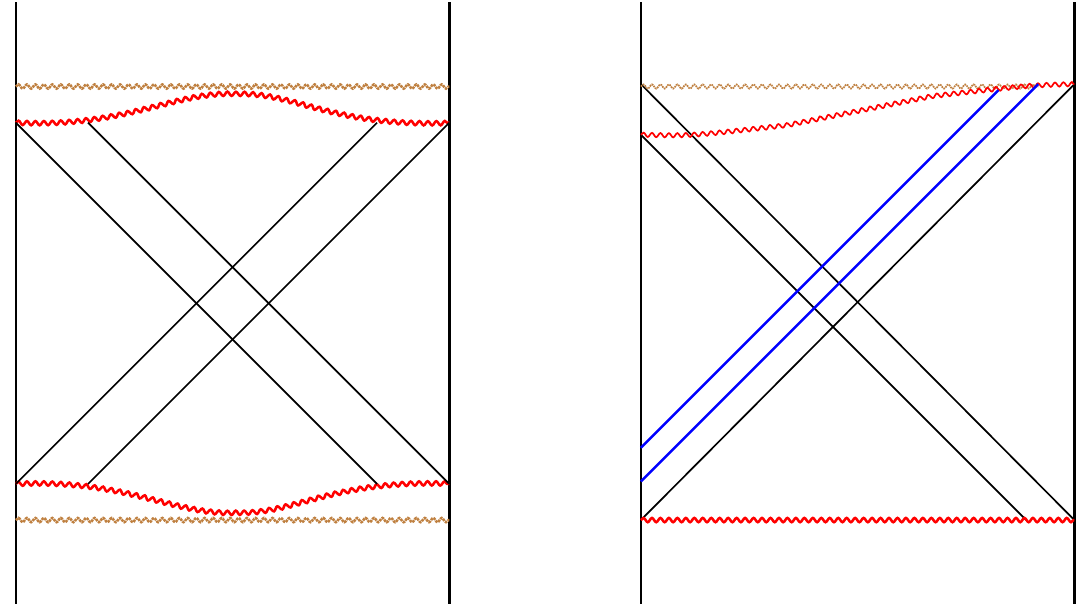
Figure 3 . Penrose diagram of the Janus deformed black hole is depicted on the left. On the right, we depict the deformation of AdS 2 black hole where only H l is deformed in a time dependent